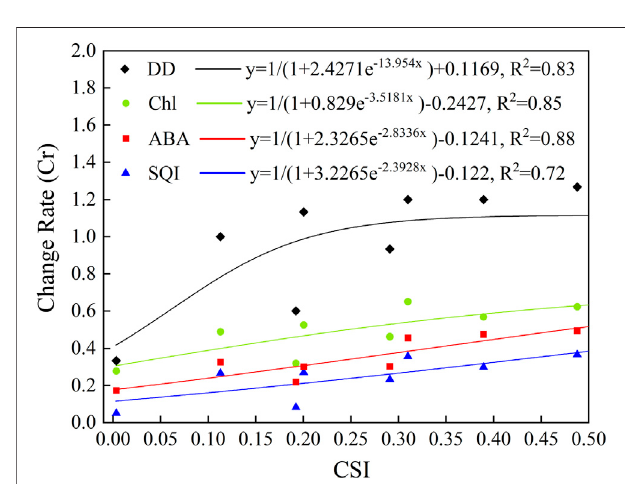
FIGURE 6 | Relationships between comprehensive intensity of HTHH ( CSI ) and physiological indexes of